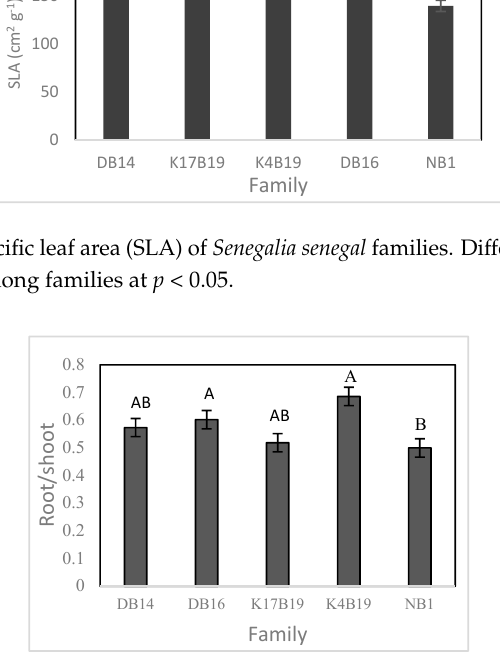
Figure 8. Variation of root/shoot ratio among families of Senegalia senegal seedlings. Different letters on bars mean significant differences among families at p < 0.05.